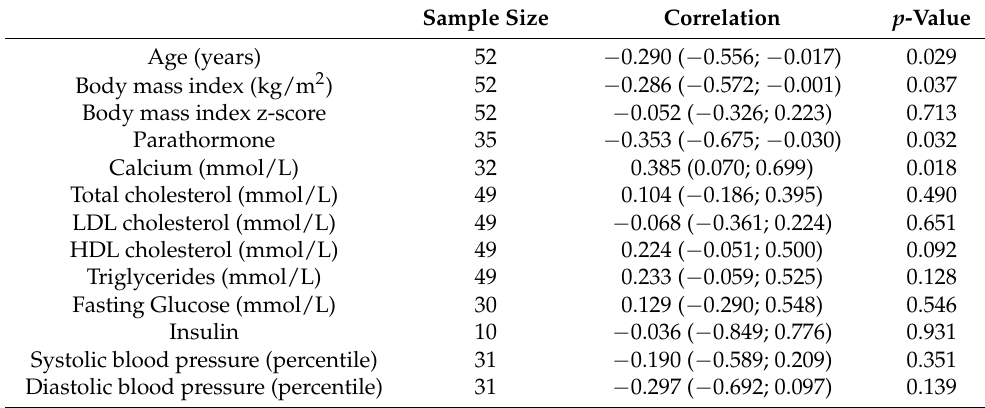
Table 2. Association between vitamin D levels and clinical and biochemical parameters. Sample